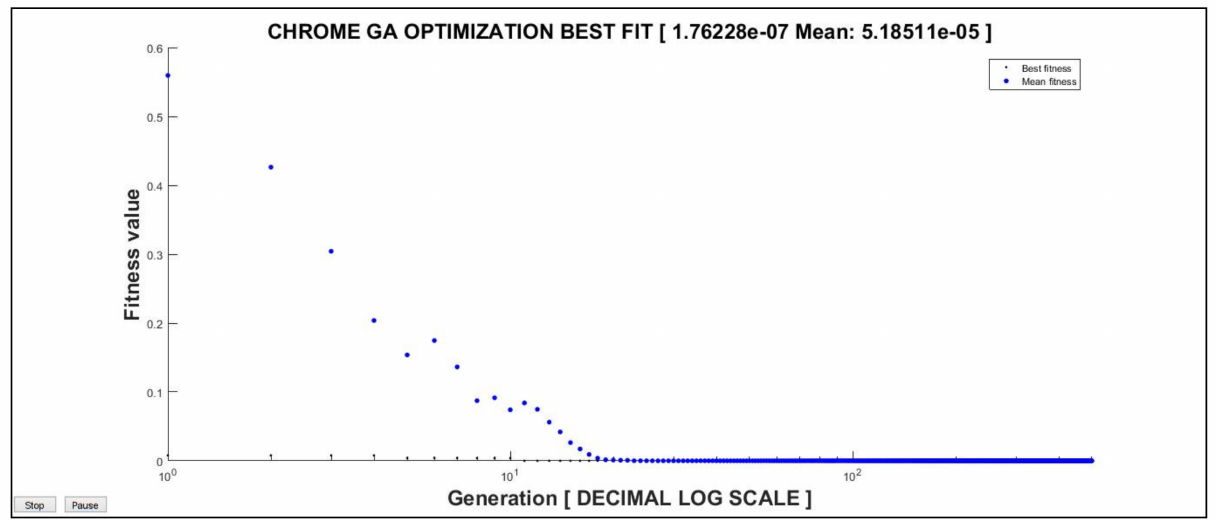
Figure 1. Chrome GA results (first stage of optimization) for best fit across generations (500). Results are accurate in magnitude orders. Best Fit results 1.76 × 10 − 7 and Mean 5.19 × 10 − 5